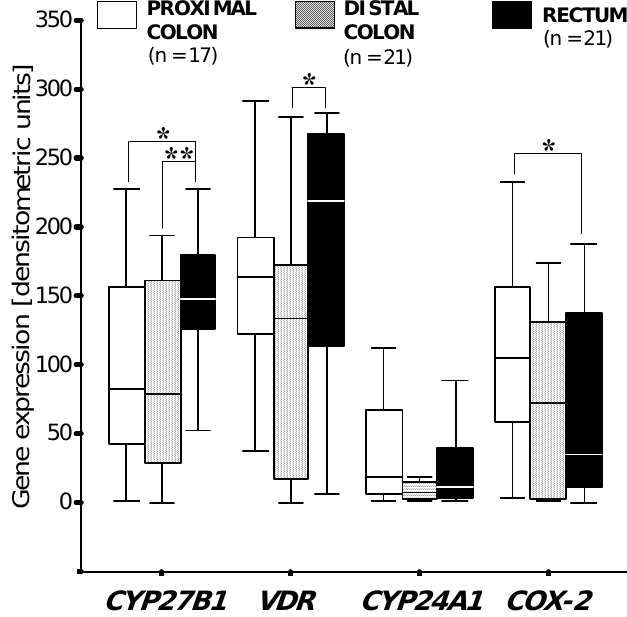
Figure 3. mRNA expression of VDR , CYP27B1 , CYP24A and COX-2 in low grade cancerous lesions at different locations in the colorectum. Results of semi-quantitative PCR (see Methods) are shown as boxplots of medians (from n patients per group). Asterisks indicate statistical significance (*, p < 0.05; **, p < 0.01). DISTAL RECTUM COLON